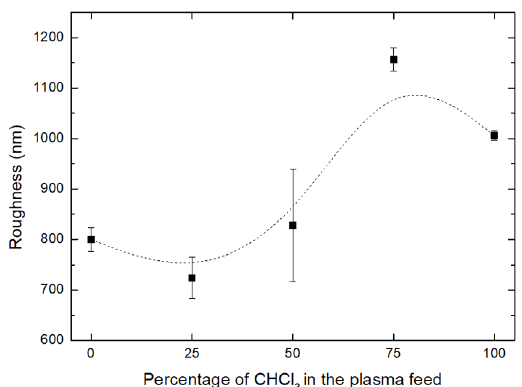
Figure 7. Surface roughness as a function of C